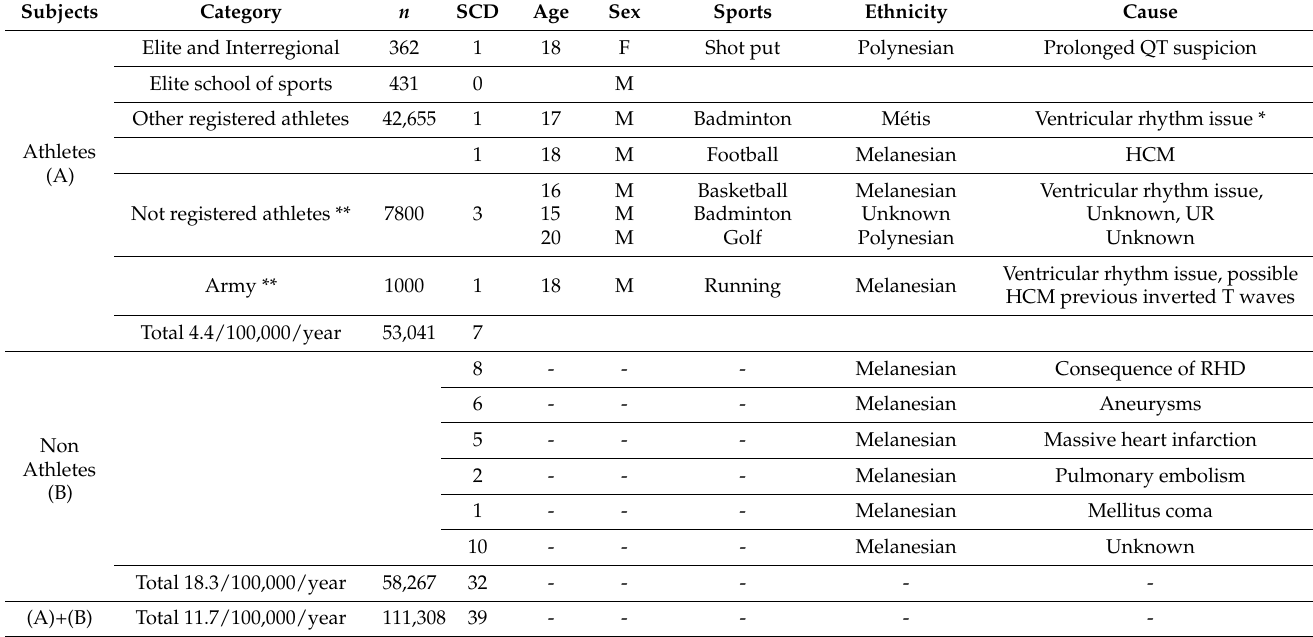
Table 1. Sudden cardiac death (SCD) in athletes and non-athletes registered between 2012 and 2014 in the New Caledonian population 10–40 age group: Poly = Polynesian, Mel = Melanesian, HCM = hypertrophic cardiomyopathy, WPW = Wolff– Parkinson–White, RHD = rheumatic heart disease, UR = un resuscitated after electric shock, * resuscitation after an SC arrest and an electric shock, ** estimation.